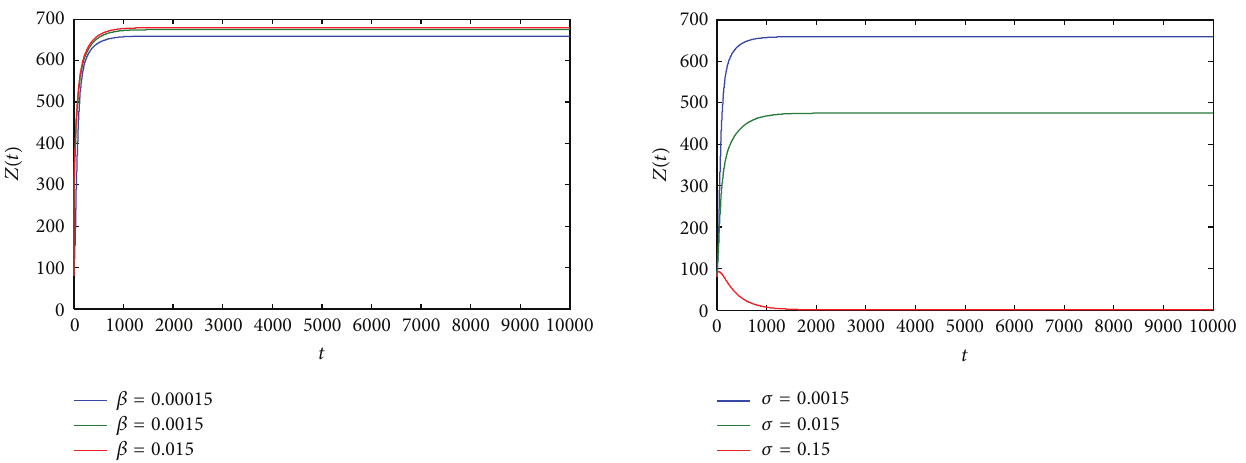
Figure 5: Size of the spreader class over time under different latent rate 𝛽 with 𝜀 = 3 , 𝑘 1 = 0.00005 , 𝑘 2 = 0.002 , 𝑘 3 = 0.004 , 𝑘 4 = 0.0002 , 𝜇 = 0.00005 , 𝜎 = 0.0015 , 𝛼 = 0.015 , 𝜃 = 0.0001 , and 𝜆 = 0.6 .